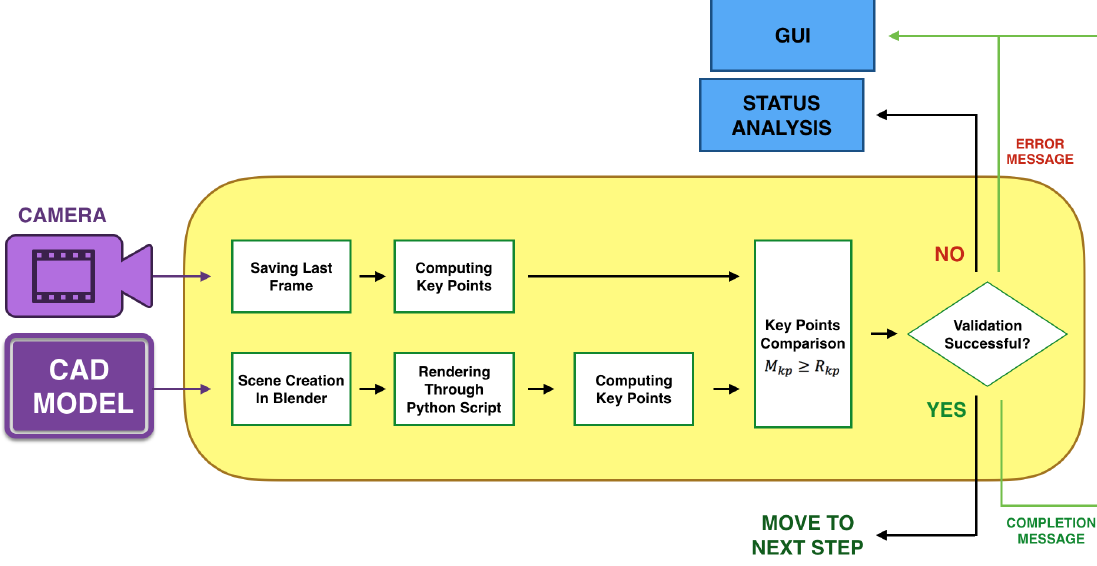
Figure 6. Operations performed by the validation